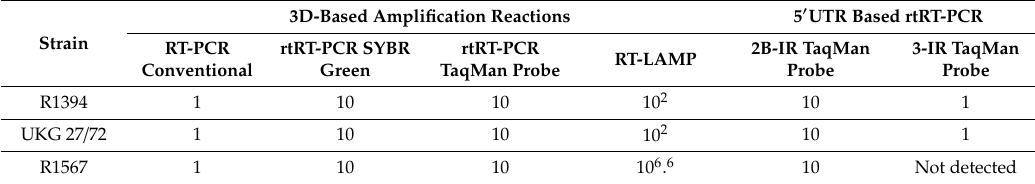
Table 2. Comparison of the analytical sensitivity of the six molecular assays. Strain